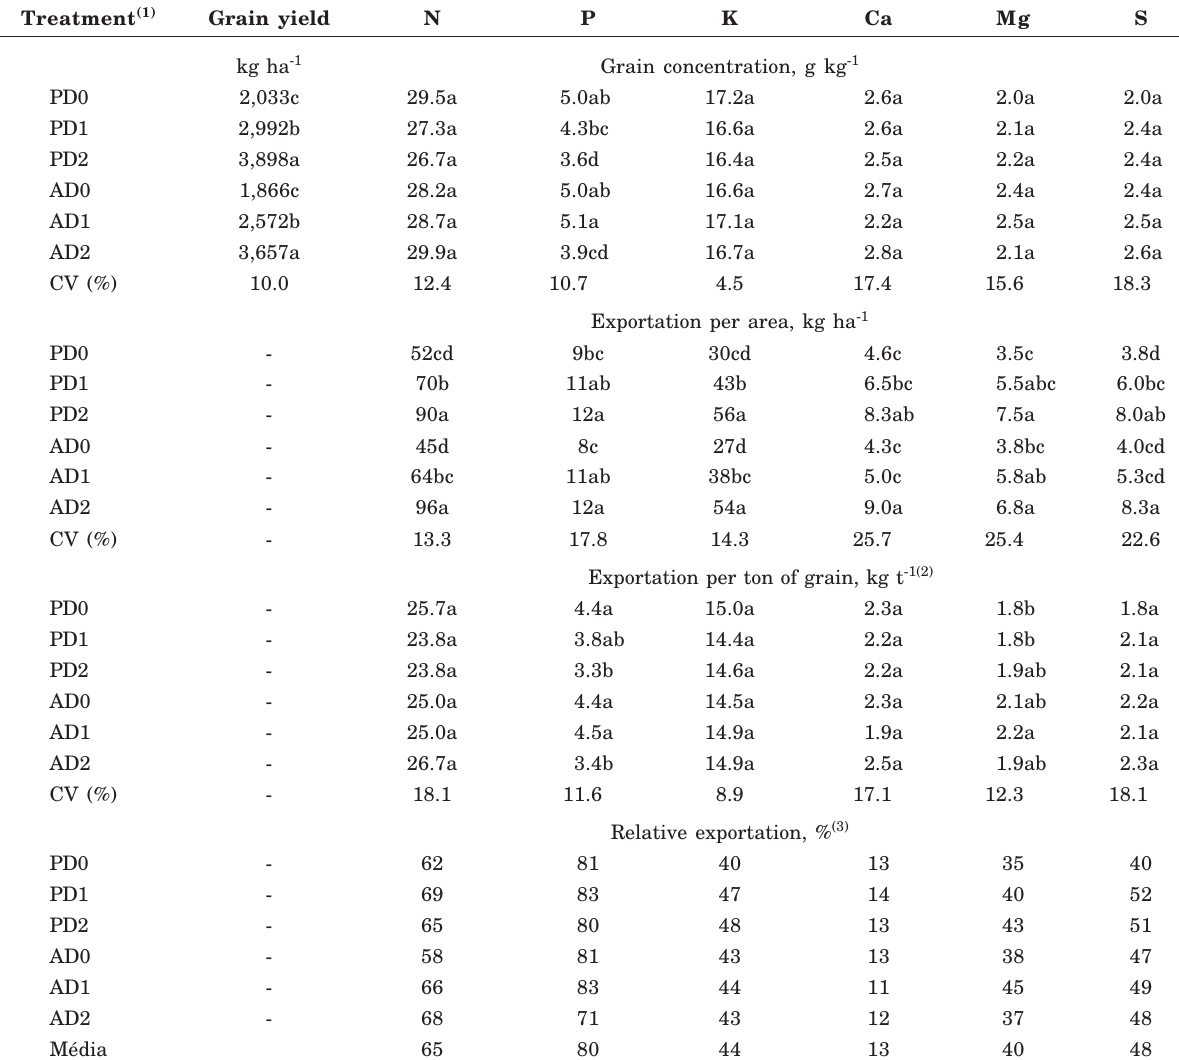
Table 3. Grain yield, nutrient concentration in grain, nutrient exportation per area, nutrient exportation per ton of grain, and relative nutrient exportation by common bean cultivars, under different levels of